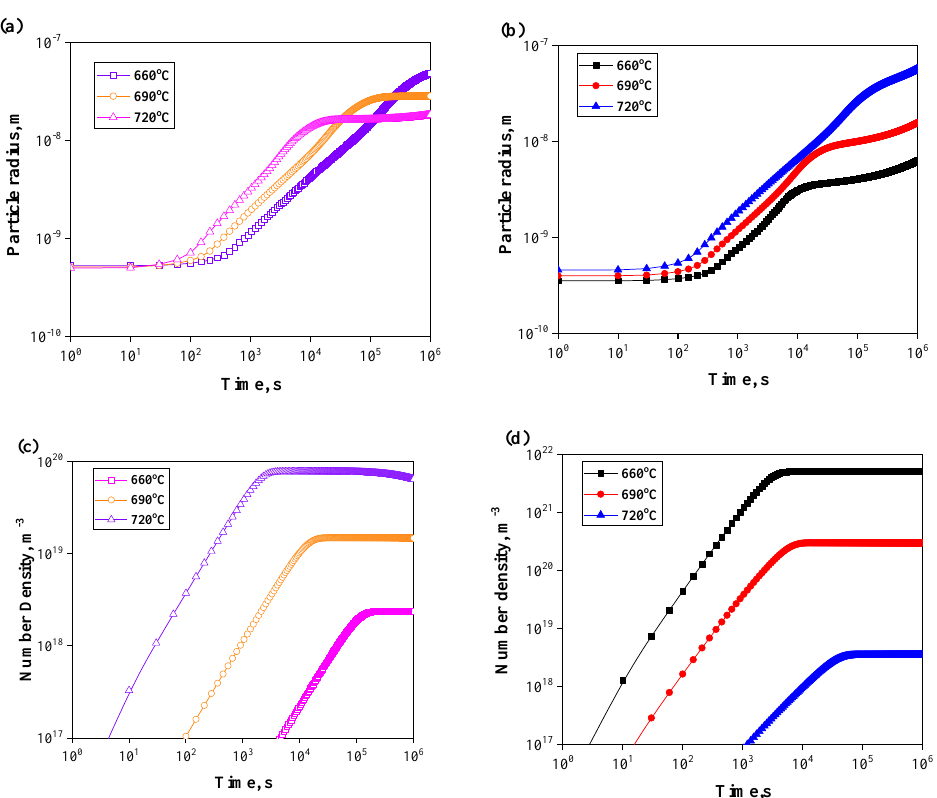
Figure 4. Radius and number density of precipitates during isothermal treatment at different temperatures: ( a ) radius of TiC, ( b ) radius of (Ti x ,V 1 − x )C, ( c ) number density of TiC and ( d ) number density of (Ti x ,V 1 − x )C.